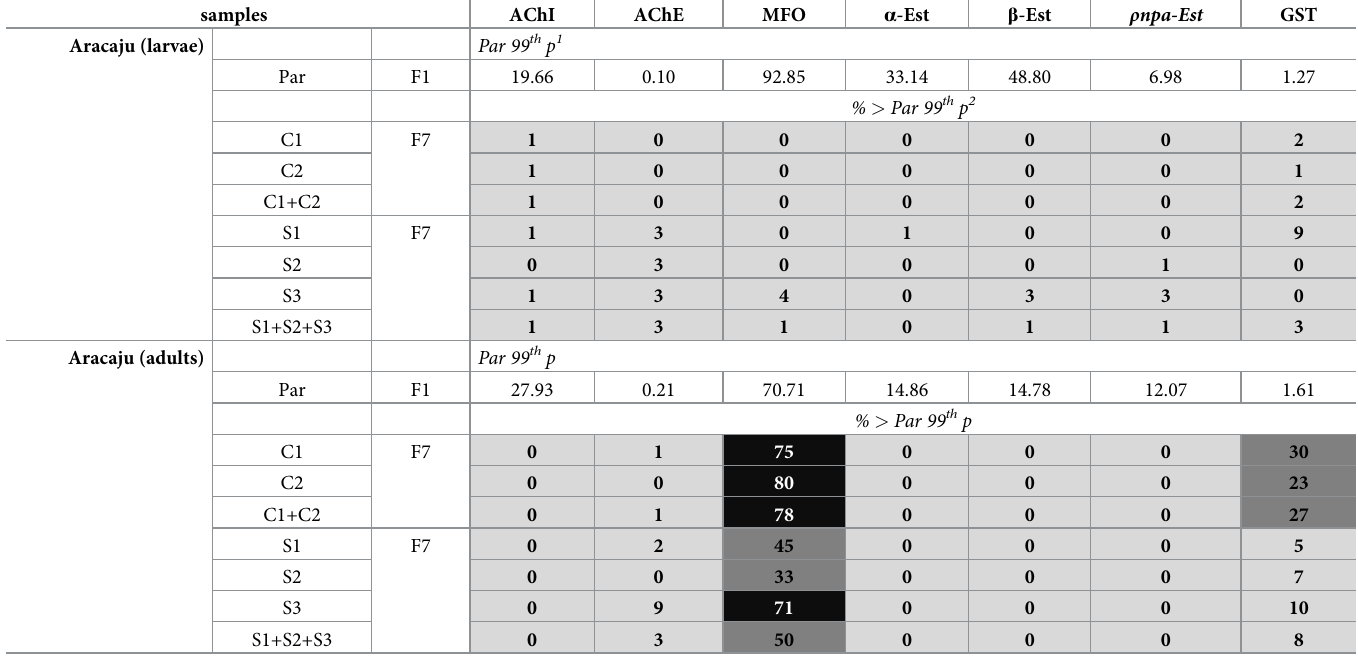
Table 3. Quantification of detoxifying enzymes and acetylcholinesterase activity in Aracaju A . aegypti exposed to selection with malathion—Comparison with the 99 th percentile of the parental population. samples